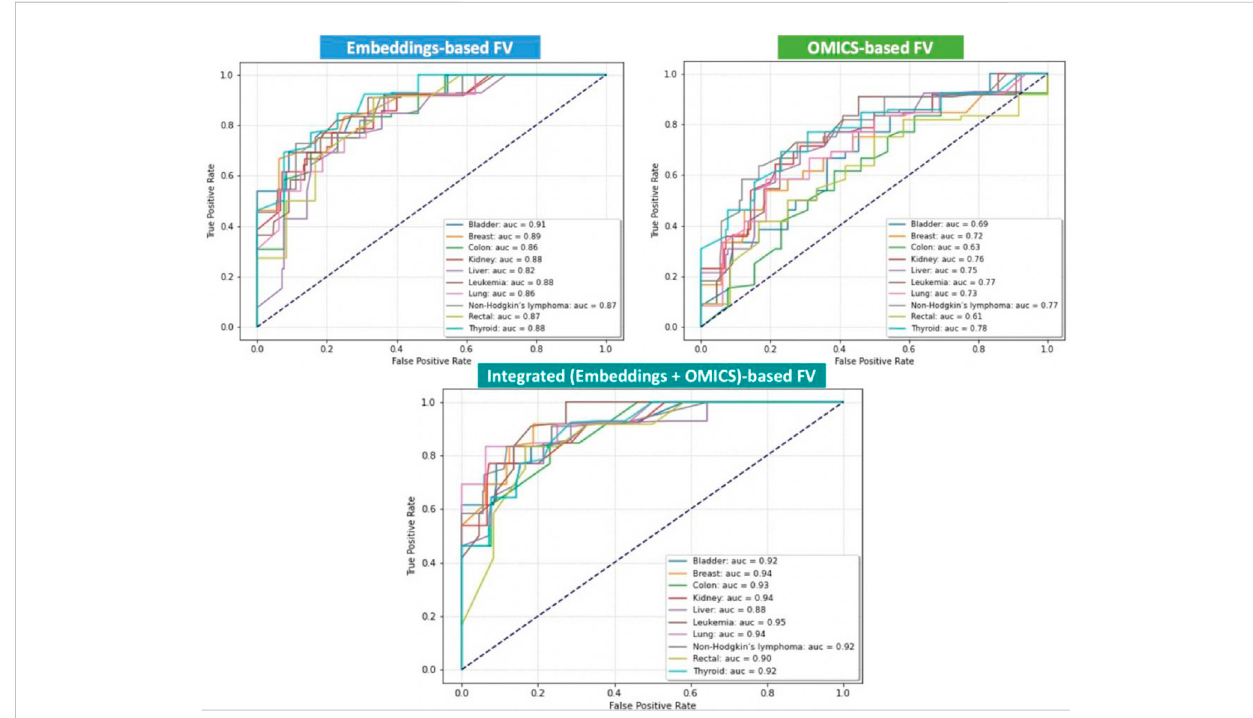
FIGURE 3 PredictionperformancesoftheDL-basedOncoRTTmodelusingthreedifferentsetsofFVfor10cancertypesintermsofAUC.Thedashedlineisthe null model (AUC =